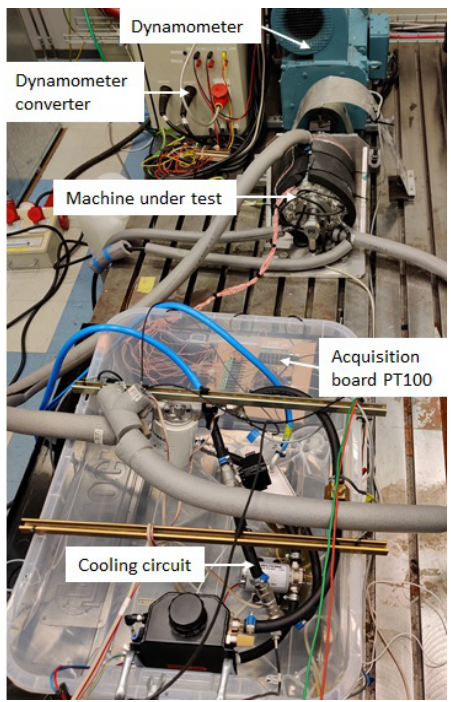
Figure 11. Picture of calorimetric test setup, showing the thermal insulation of the machine, oil hoses, and phase